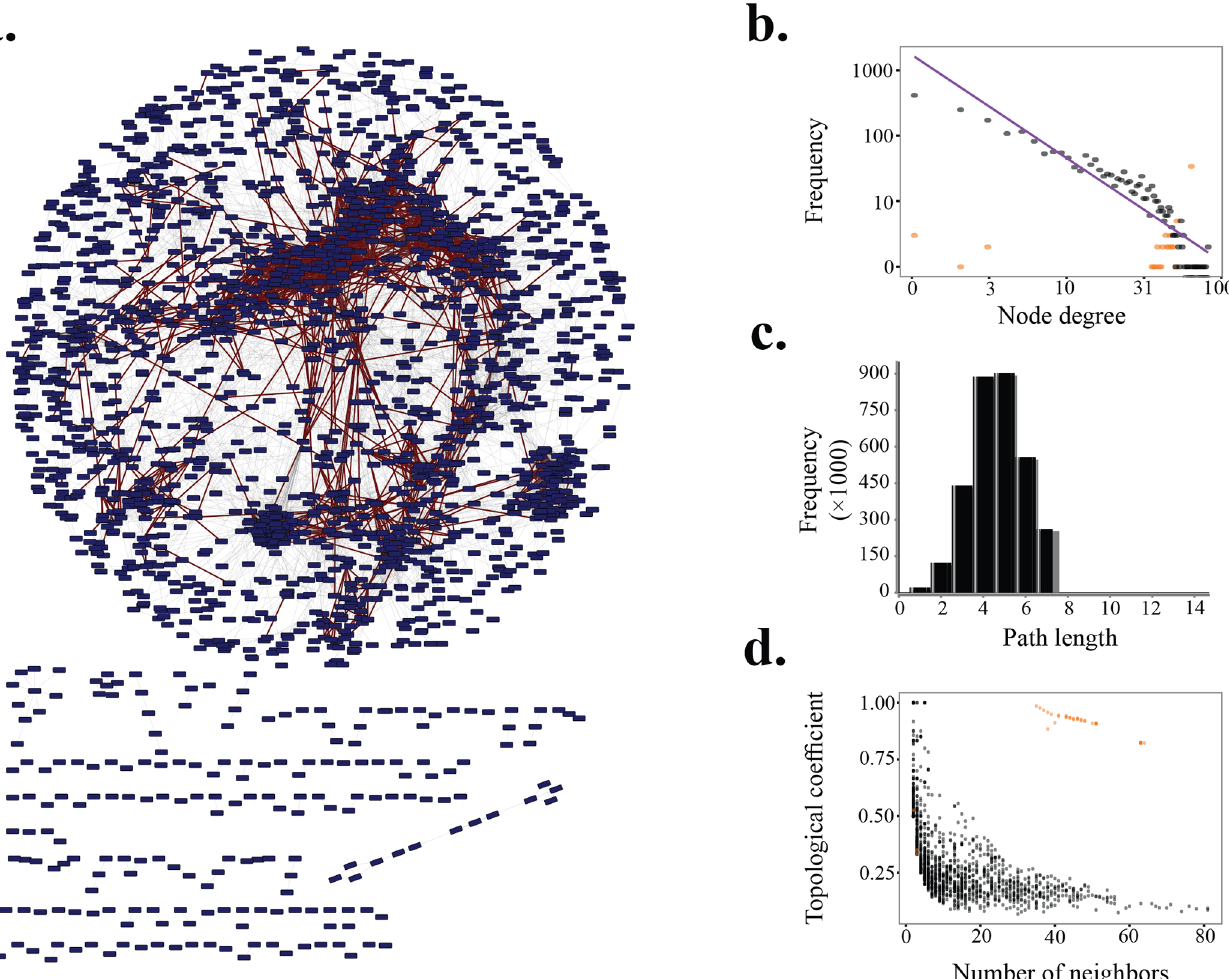
Fig 4. Topological characteristics of TbCF net. a) Representation of TbCF net. Red interactions correspond to those that were reproducibly identified in both GG and IEX fractionation experiments. b) Distribution of number of nodes as a function of number of node neighbors (i.e., node degree) in logarithmic scale. Interactions between ribosomal and non-ribosomal proteins were analyzed separately and were distinguished in the graph by yellow and black colors, respectively. c) Distribution of shortest path lengths in the TbCF net. In accordance with the small world property of biological networks, the path length is usually small with a unimodal peak at five. To avoid bias, ribosomal proteins were discarded for this analysis. d) Distribution of the topological coefficient of nodes as a function of node degree. Similar to hub degree analysis, interactions between ribosomal and non-ribosomal proteins were analyzed separately and were distinguished in the graph by yellow and black colors,